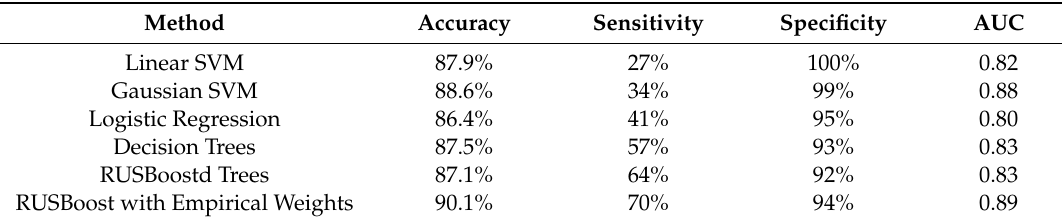
Table 2. Comparison of classifier performance.